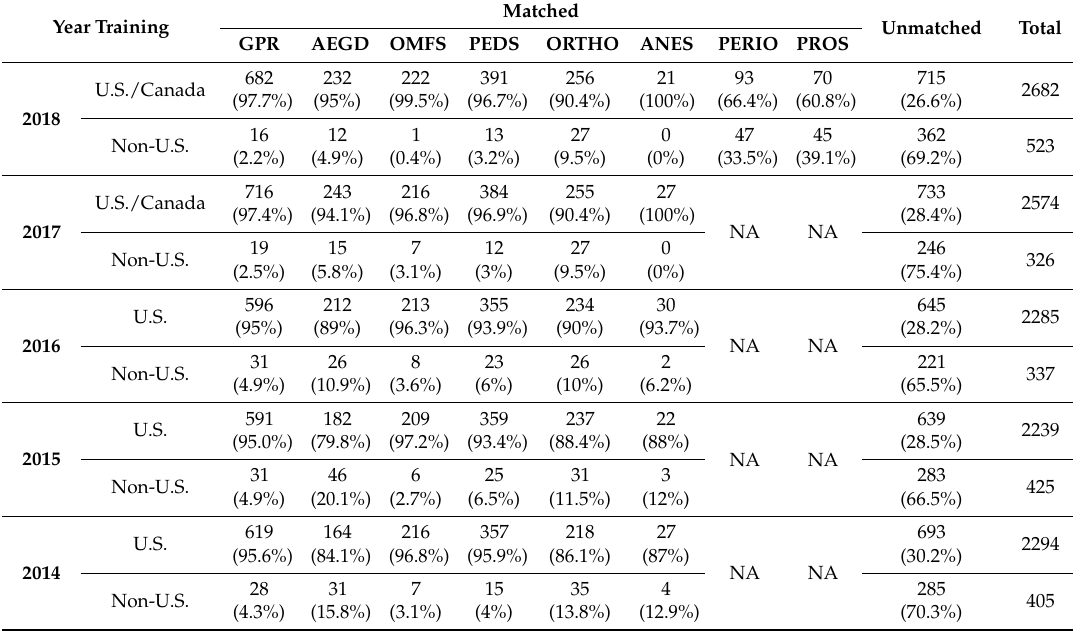
Table 3. Number of students from U.S, Canadian and foreign dental schools matched to postdoctoral dental residency programs, 2014–2018. Source: National Matching Services Inc. (Toronto, ON, Canada) Postdoctoral dental matching program: statistics for applicants